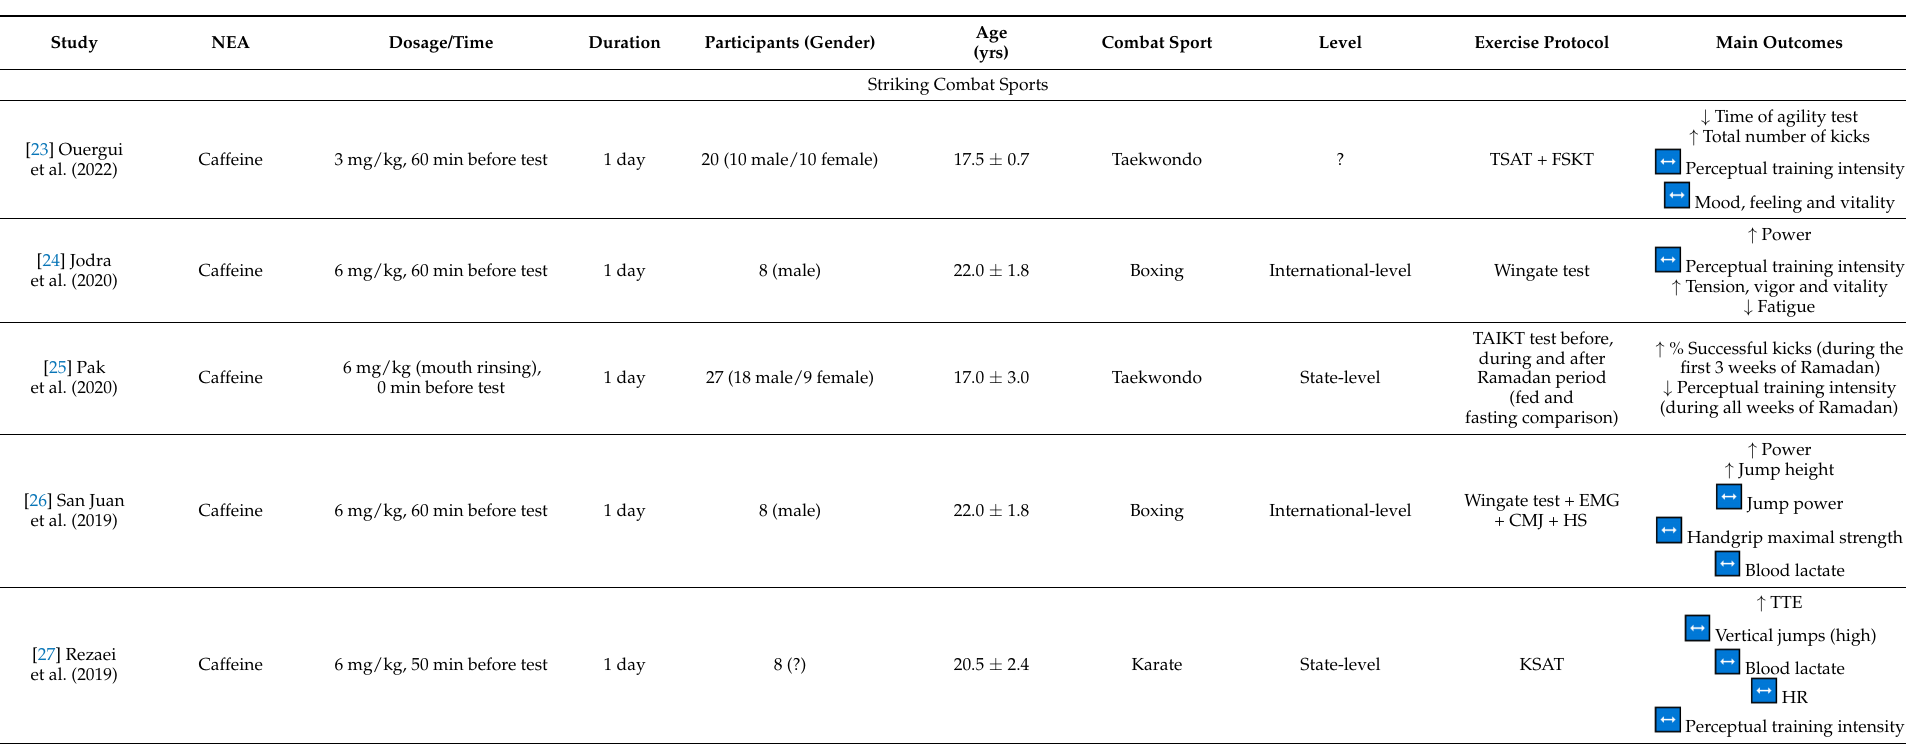
Table 2. Included studies of nutritional ergogenic aids in combat sports. 1RM: one-repetition maximum; BA: beta-alanine; BDNF: brain-derived neurotrophic factor; CAF: caffeine; CMJ: countermovement jump; EMG: electromyography; FFA: free fatty acids; FSKT: frequency speed of kick test multiple; HIIR: high intensity interval run; HS: handgrip maximal strength; IGF-1: insulin-like growth factor 1; JGST: judogi grip strength test; KSAT: karate-specific aerobic test; MMA: mixed martial arts; PSTT: progressive specific taekwondo test; PWPT: Pittsburgh wrestling performance test; SB: sodium bicarbonate; SFJT: special fitness judo test; TAIKT: taekwondo anaerobic intermittent kick test; TSAT: taekwondo-specific agility test; TTE: time to exhaustion; UBISP: upper-body intermittent sprint performance